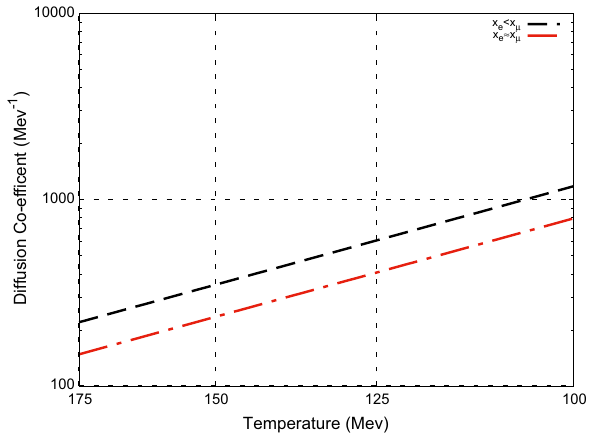
Fig. 1 Diffusion coefficient of neutrons in the electron, neutron and muon plasma. The (black) dashed line denotes x e < x μ and the (red) dot-dashed line denotes x e ≈ x